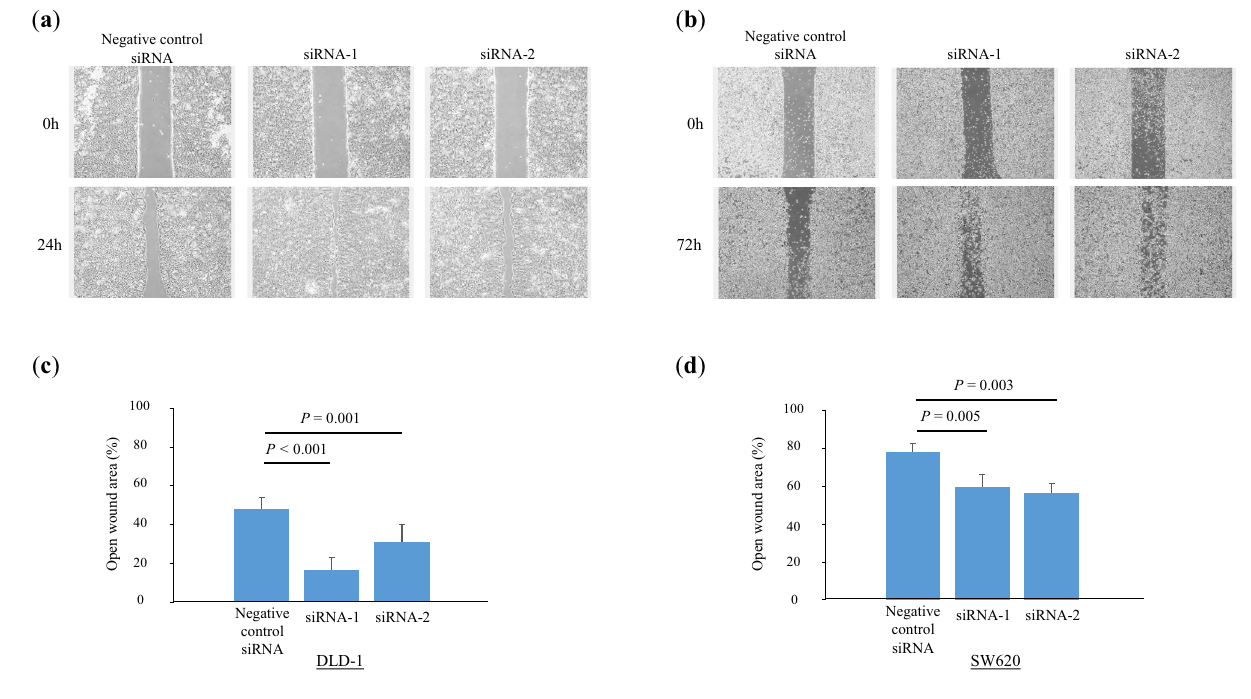
Figure 3. Wound-healing assay in colorectal cancer cells. ( a , b ) Representative images of wound healing in ( a ) human colon cancer cell line DLD-1 cells and ( b ) human colon cancer lymph node metastasis cell line SW620 cells treated with siControl and siSmurf2. ( c , d ) Open wound area was measured under a microscope at 50 × magnification in ( c ) human colon cancer cell line DLD-1 cells and ( d ) human colon cancer lymph node metastasis cell line SW620 cells.